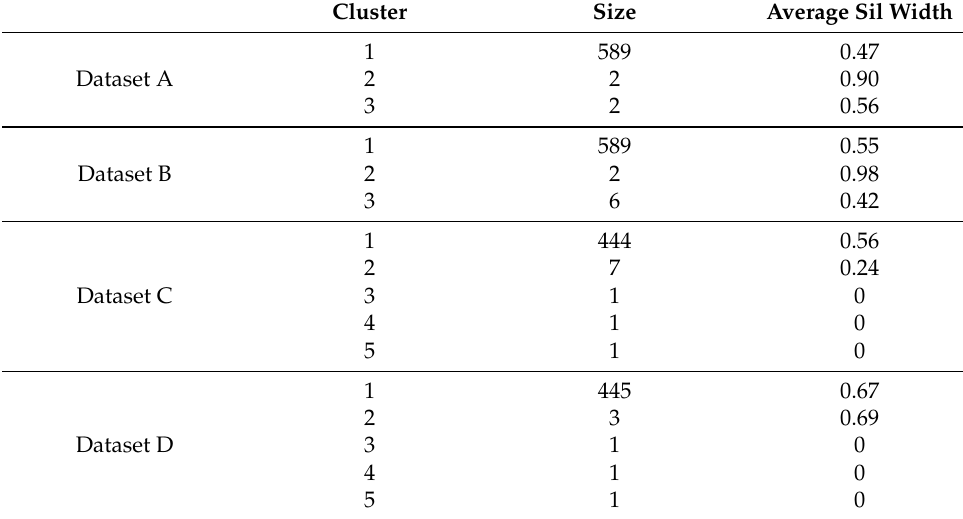
Table 5. Silhouette coefficient value of each dataset. Cluster Size Average Sil